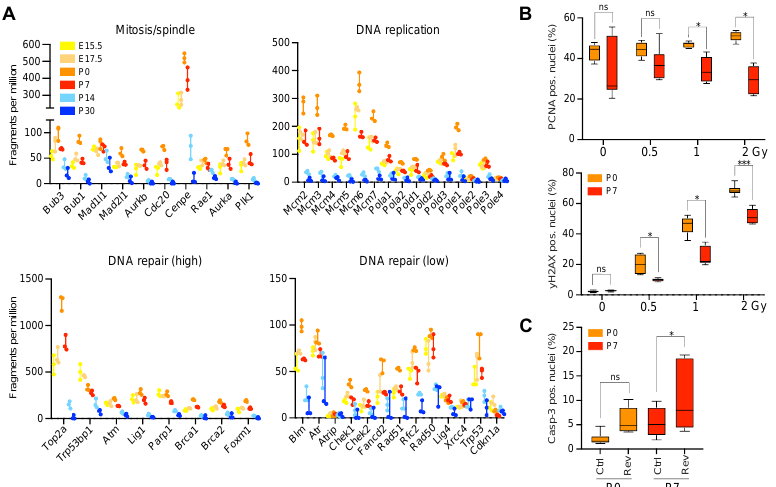
Figure 3. Early postnatal CGNPs are sensitive to DNA damage and CIN-inducing stressors. ( A ) Plots showing relative gene expression levels (in fragments per million) of individual genes involved in mitosis/spindle (upper left panel), DNA replication (upper right panel), and DNA repair (relatively high expressed genes: lower left panel, relatively low expressed genes: lower right panel) in CGNPs isolated between embryonic day E15.5 and postnatal day P30. Results represent range and individual data points. n = 3 samples per developmental time point. ( B ) Box and whisker plots showing the fraction of PCNA positive (upper panel) or γ H2AX positive (lower panel) nuclei in Y-ray irradiated primary P0 (orange bars) and P7 (red bars) CGNP cultures. Radiation dose is plotted on the X -axis (Gy = Grey). Whiskers represent min to max. n = 6 biological replicates are plotted per condition. p values were determined using multiple t -tests with Holm-Sidak correction. * p < 0.05, ns = not significant. ( C ) Box and whisker plot showing the fraction of Caspase-3 positive nuclei in primary P0 (orange bars) and P7 (red bars) CGNP cultures treated with 250 nM of reversine or DMSO (Ctrl). Whiskers represent min to max. At least n = 8 biological replicated are plotted per condition. p values were determined using an ordinary one-way ANOVA with Sidak correction. * p < 0.05, *** p < 0.001, ns = not